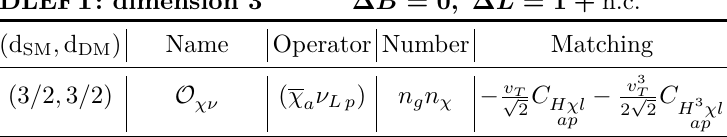
Table 24 . Dimension-three ∆ B = 0 , ∆ L = 1 operator in DLEFT. The first column gives the dimensions of the SM and DM part of the operator, the fourth column is the number of operators, and the fifth column is the additional matching contribution at the EW scale.